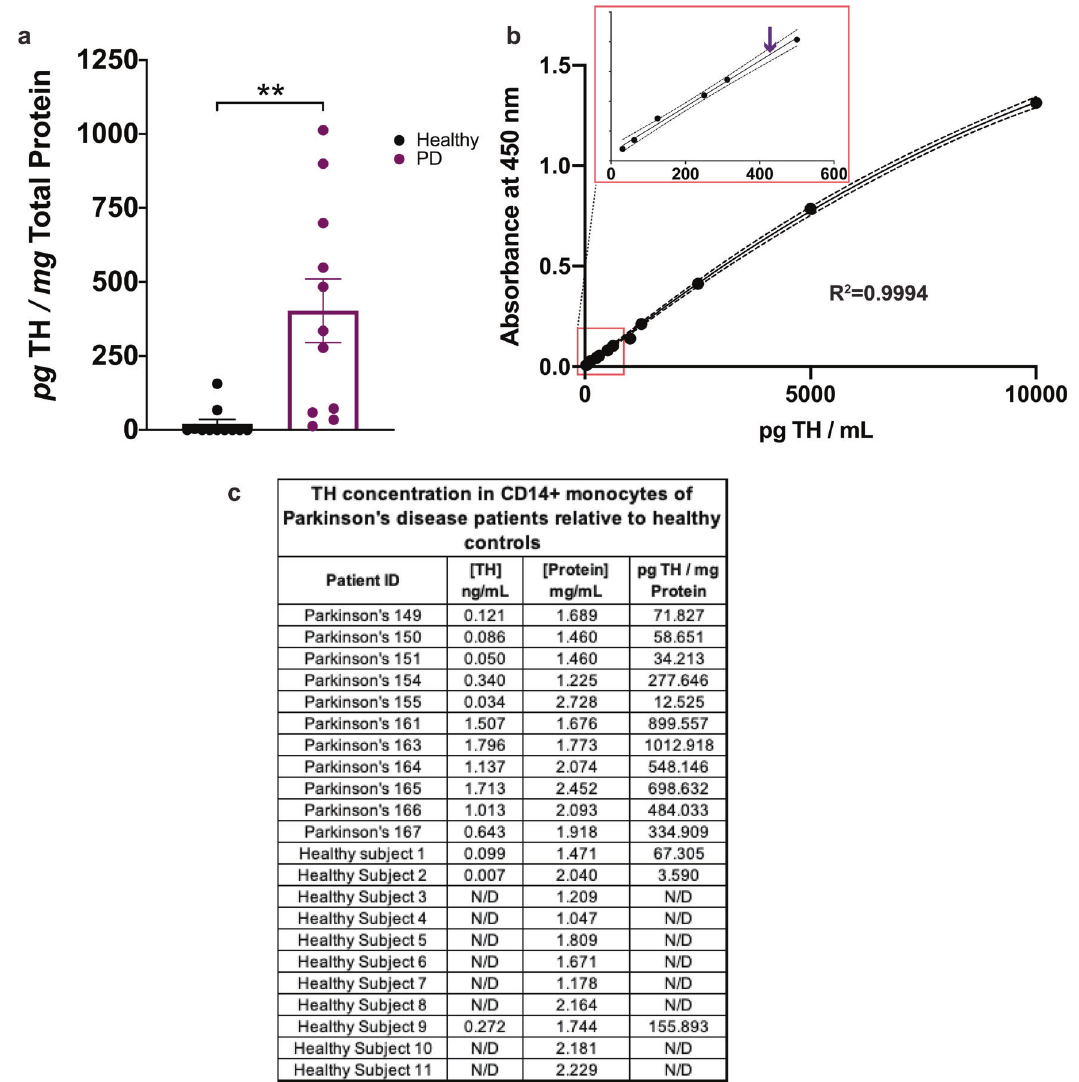
Fig. 5 TH protein is increased in CD14 + monocytes isolated from PD patients. Total CD14 + monocytes were magnetically isolated from 20 million freshly isolated PBMCs derived from whole blood of 11 PD patients and 11 healthy volunteers, immediately lysed in the presence of protease inhibitor, and stored at − 80 °C. Following protein quanti fi cation, the whole lysate from each sample was added to duplicate wells and assayed for the concentration of TH. a Monocytes isolated from PD patients express a signi fi cantly greater quantity of TH compared to equivalent monocytes isolated from healthy control subjects (unpaired two-tailed T -test, alpha = 0.05, p < 0.05). b Mean TH concentration for monocytes from PD patients plotted on a representative standard curve, with inset magnifying the lower end of the curve. c Calculations are shown by which raw TH concentration in ng/mL is normalized to total protein per sample. Samples included in a , each an independent biological replicate, are shown in c . Data are shown as